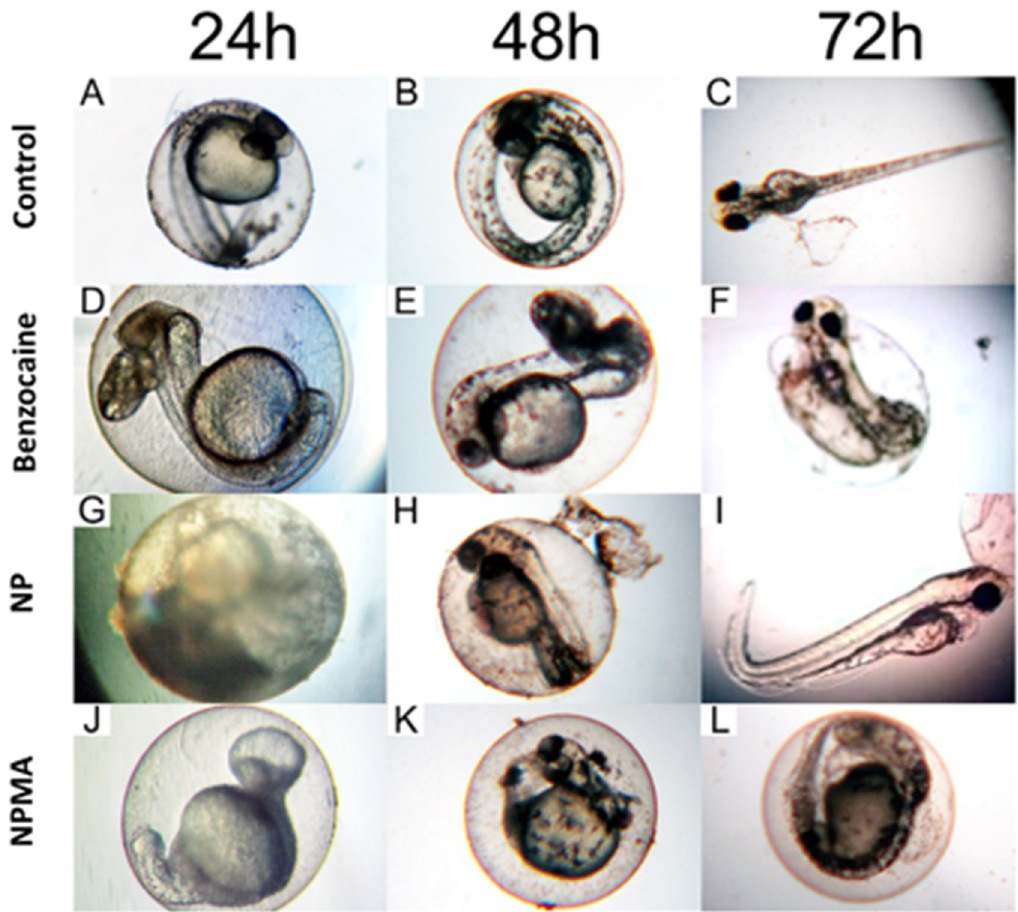
Fig 9. Sublethal effects of zebrafish embryos exposed to NP, NPMA, and BENZ. (A-C) control embryos presenting wildtype morphology. (D-F) Embryos exposed to BENZ revealed tail malformation (D and E) and pericardial edema (F). (G-I) Embryo contact with NP developed curved tail. (G and H) Nanoparticles formed aggregates deposition on the chorion surface. (J-L) NPMA exposure led to general malformation of embryos at 3.9 μ g/L -1 .